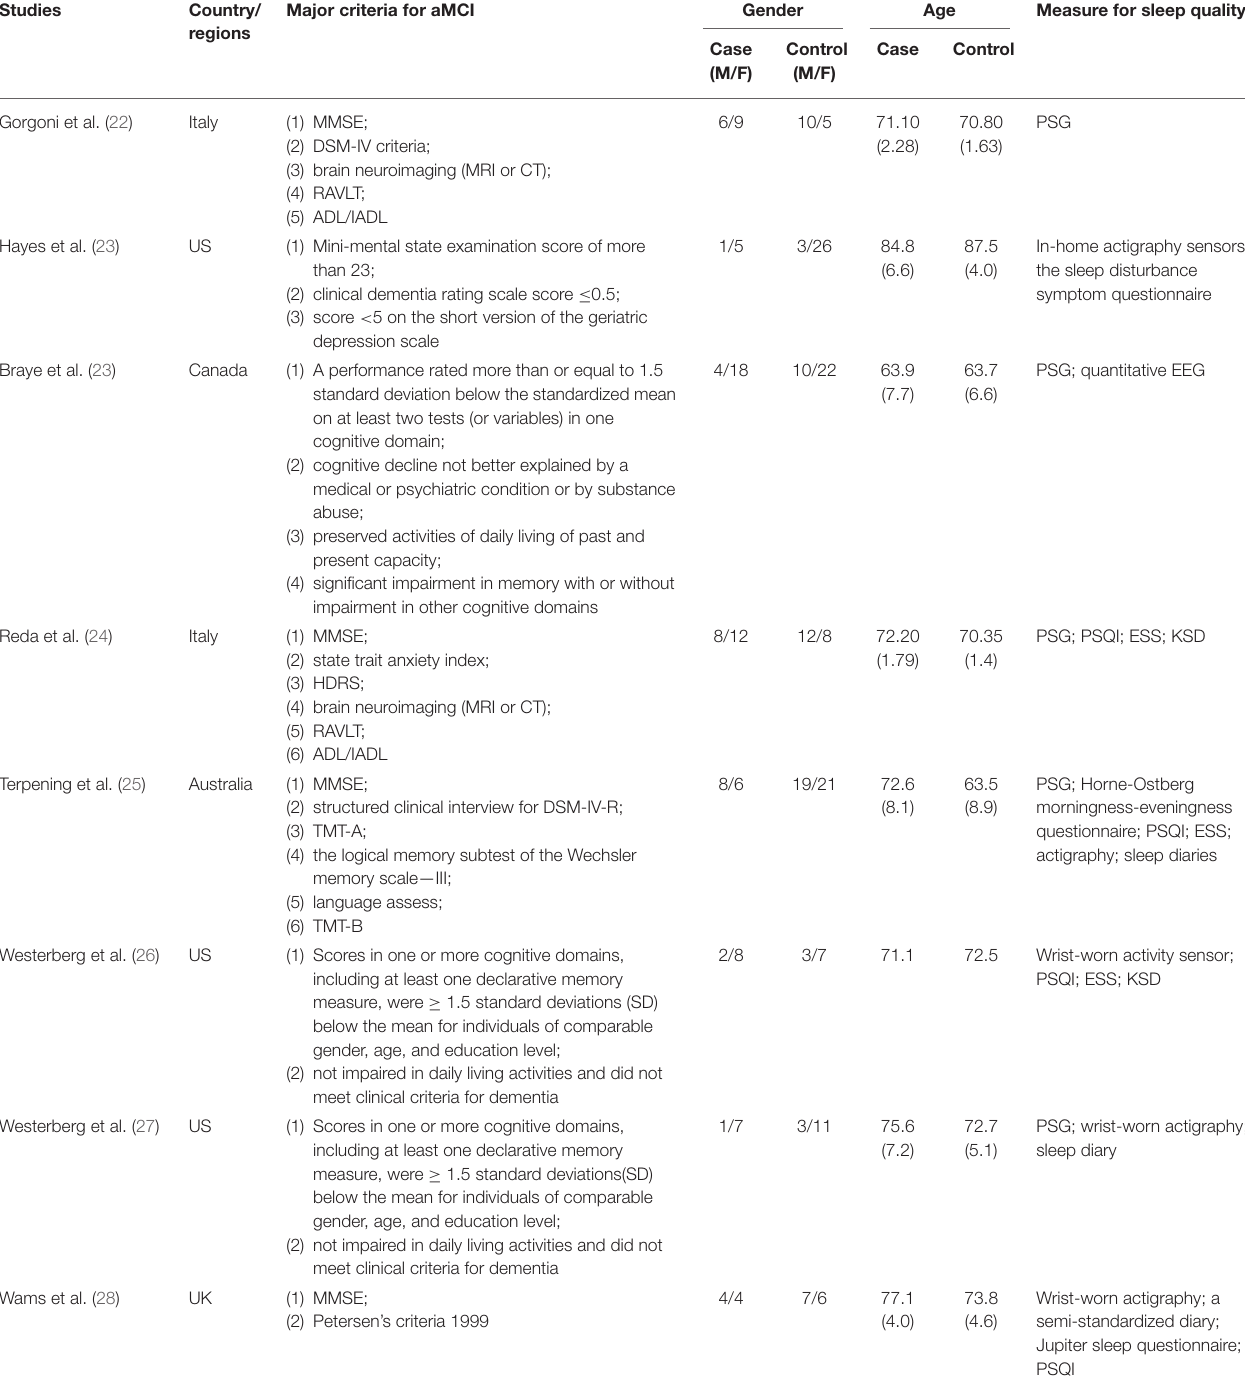
TABLE 2 | Characteristics and information of the eight studies and samples.